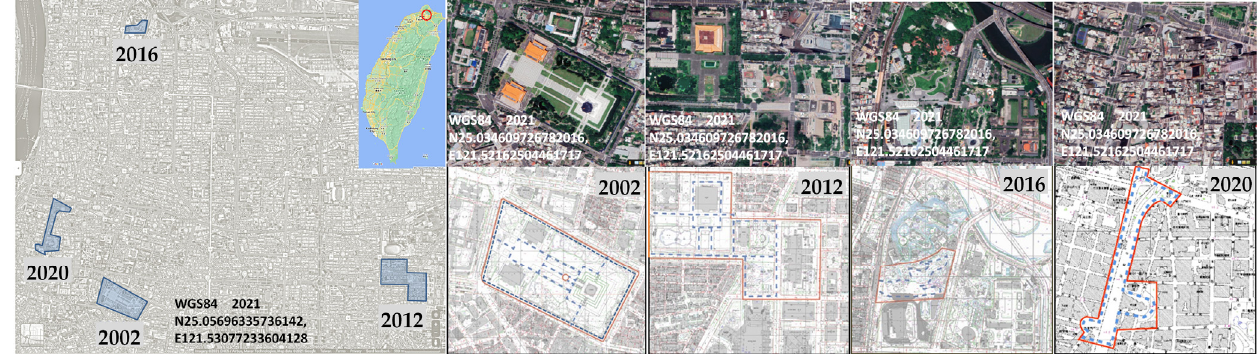
Figure 1. Layout of the Taipei Lantern Festivals (2002, 2012, 2016, and 2020), verified from a comparison of satellite images and cadastral maps.